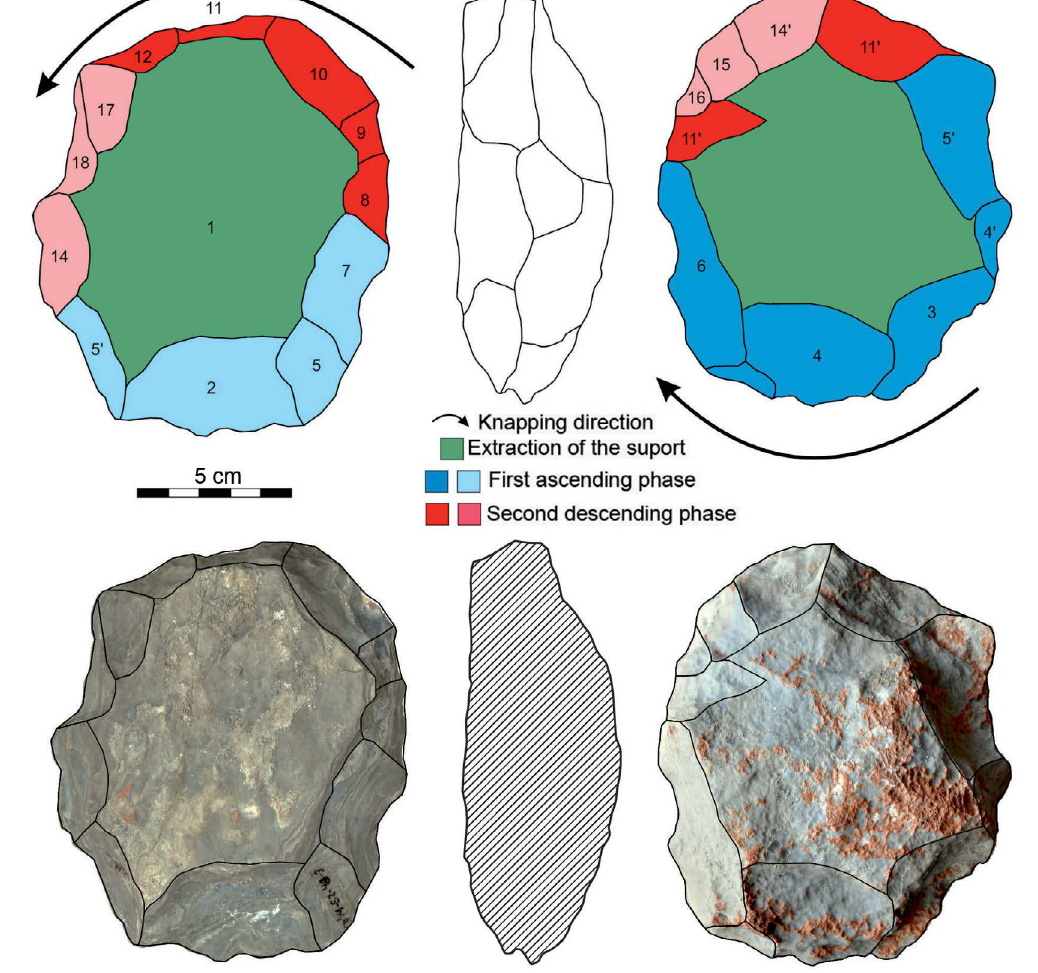
Figure 9. Diacritic scheme of knapping preform No.